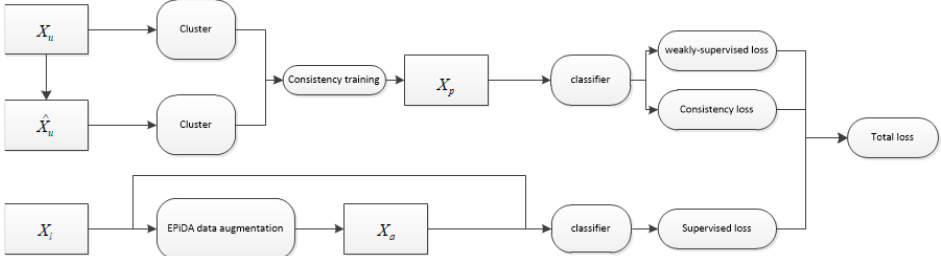
Figure 2. The illustration of the structure of the STCPC model. The STCPC is divided into two parts, the upper part is the pseudo-label generation route, and the lower part is the EPiDA data augmentation with tagged data.